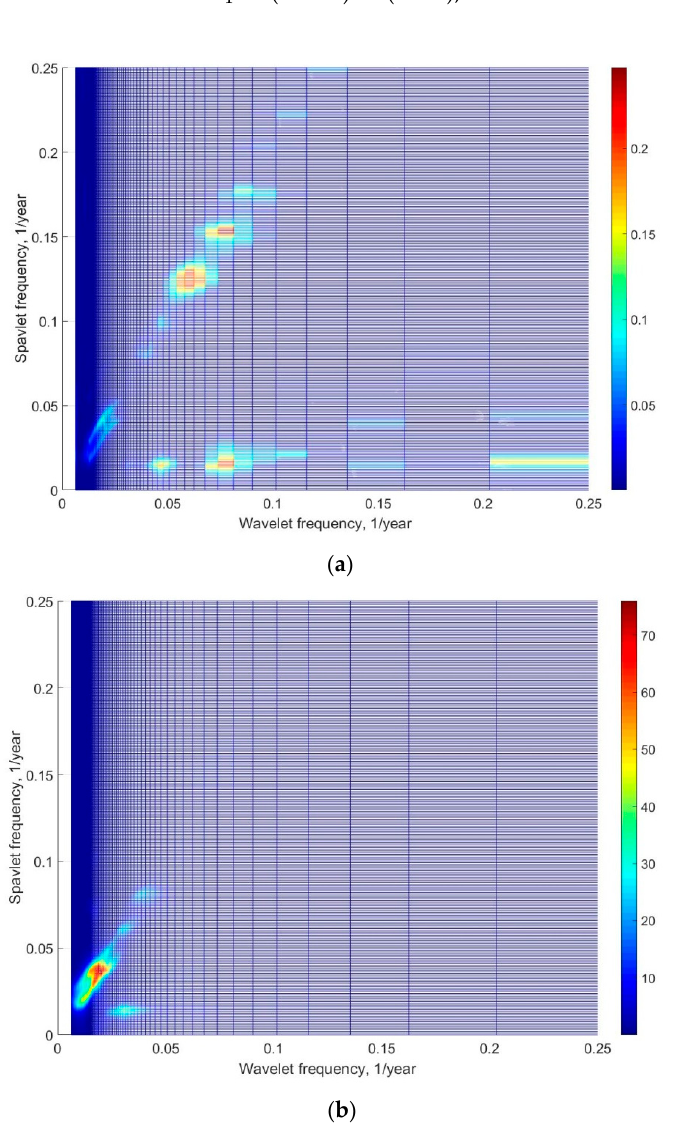
Figure 5. Spavlets of the average annual wave heights ( a ) and periods ( b ).